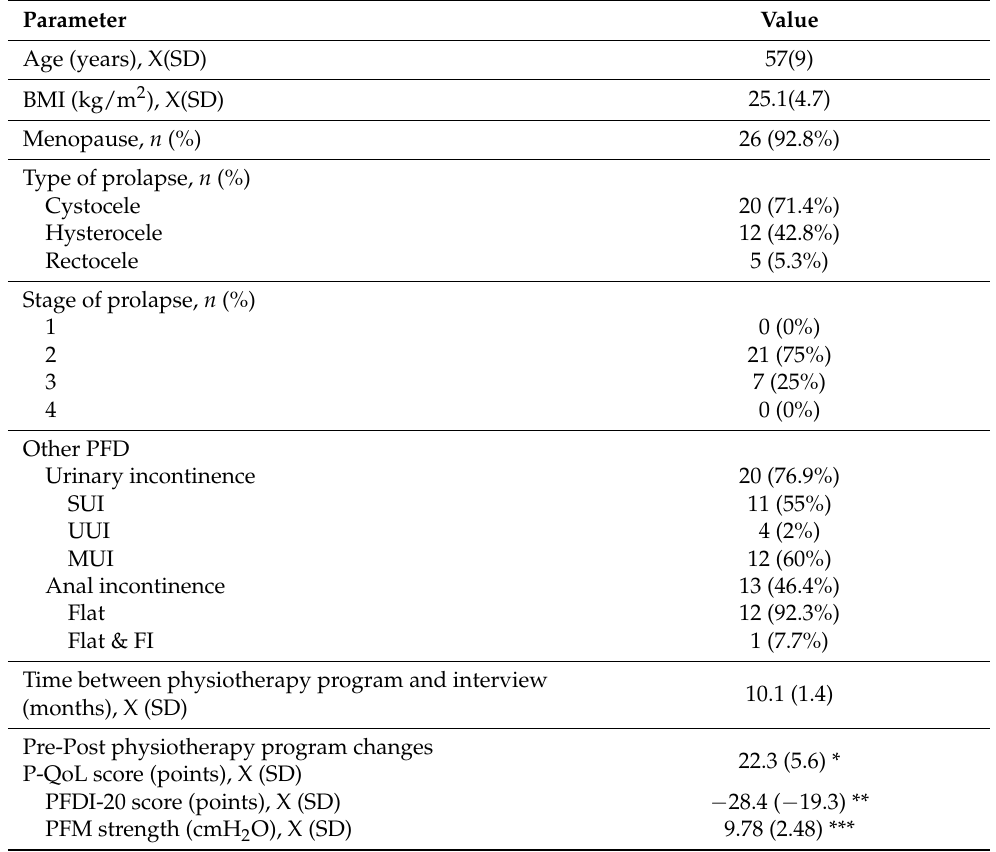
Table 1. Women’s demographics and prolapse